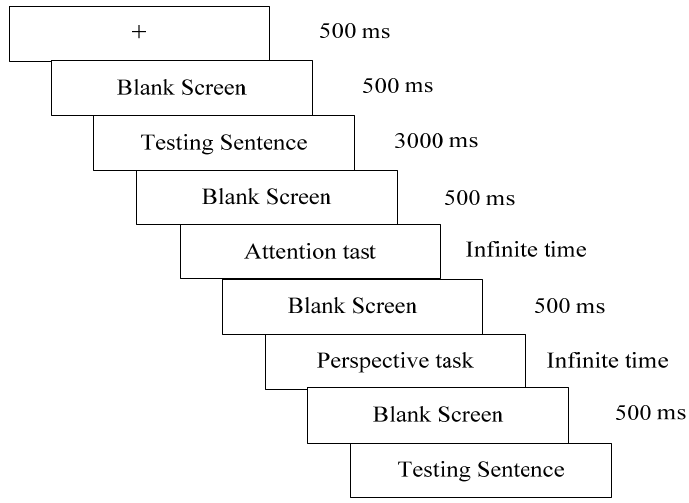
Figure 1. Procedure for one sentence.